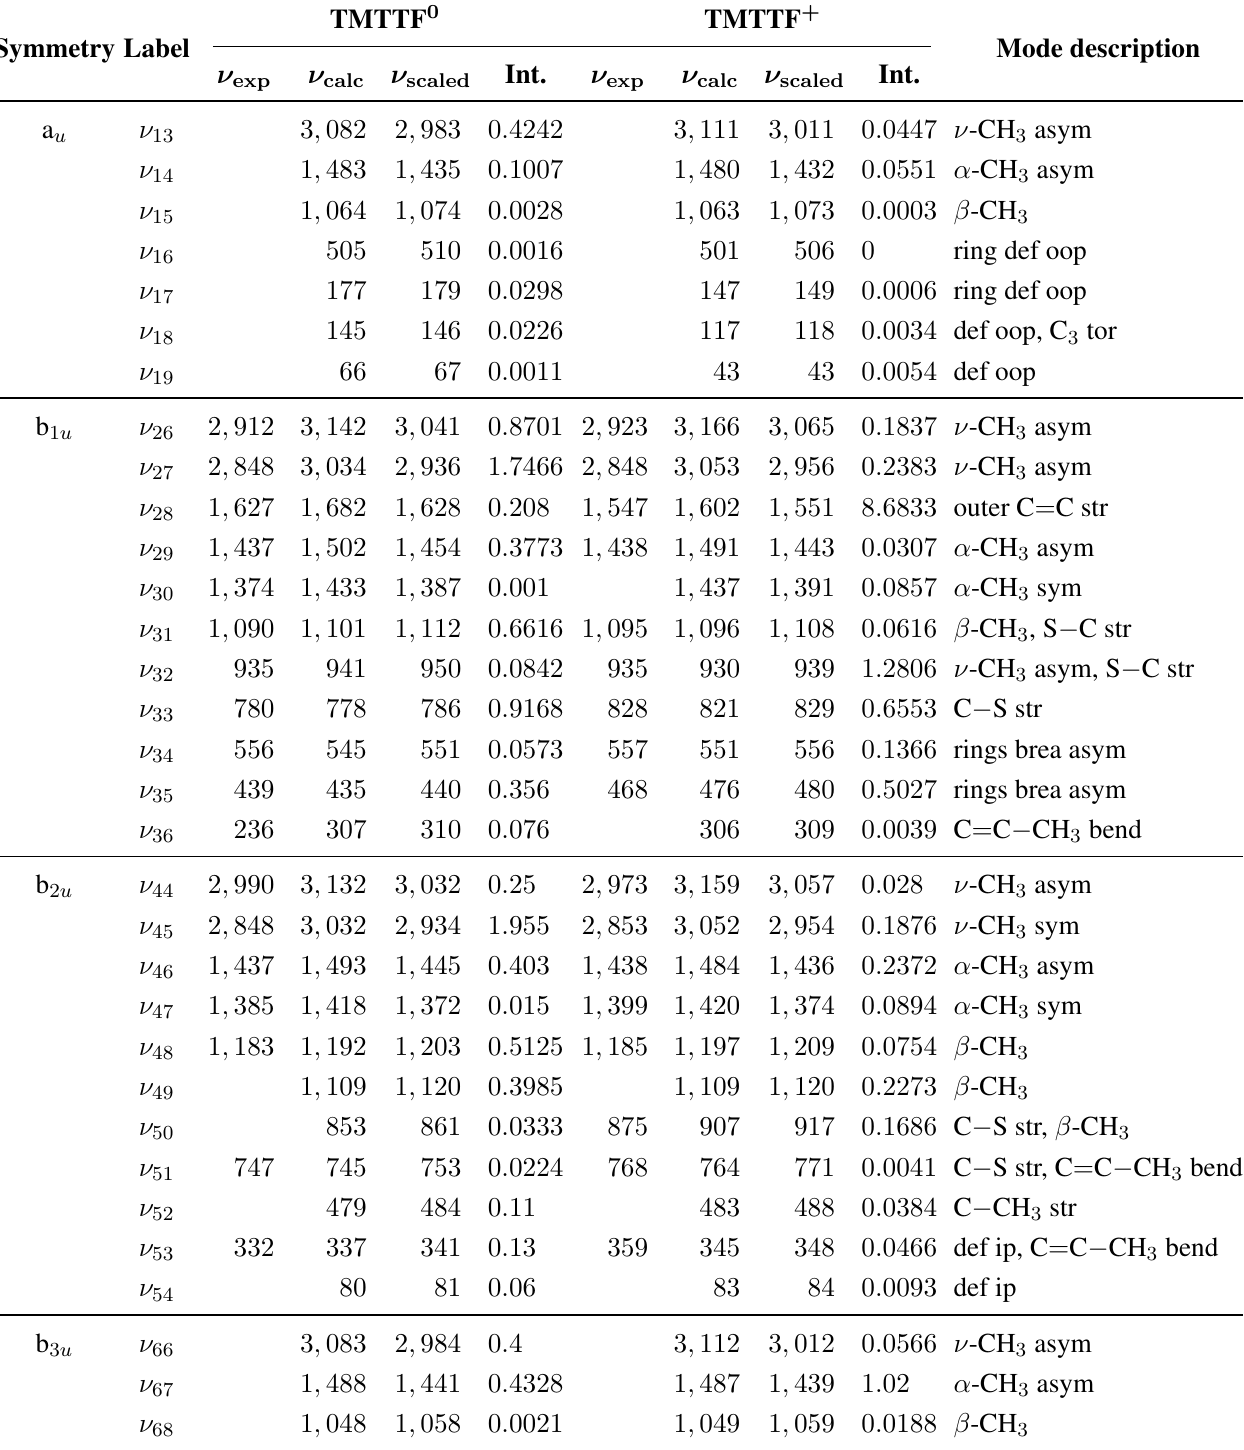
Table A2. Calculated frequencies (in cm − 1 ) and infrared intensities (given in D 2 amu − 1 ˚A − 2 ) of the ungerade modes of TMTTF 0 and TMTTF + . The experimental values are extracted from [59]. The eigenvectors are sketched in Figures A3–A5. The following abbreviations are used: Int.: Intensity, asym: asymmetric, sym: symmetric, def: deformation, ip: